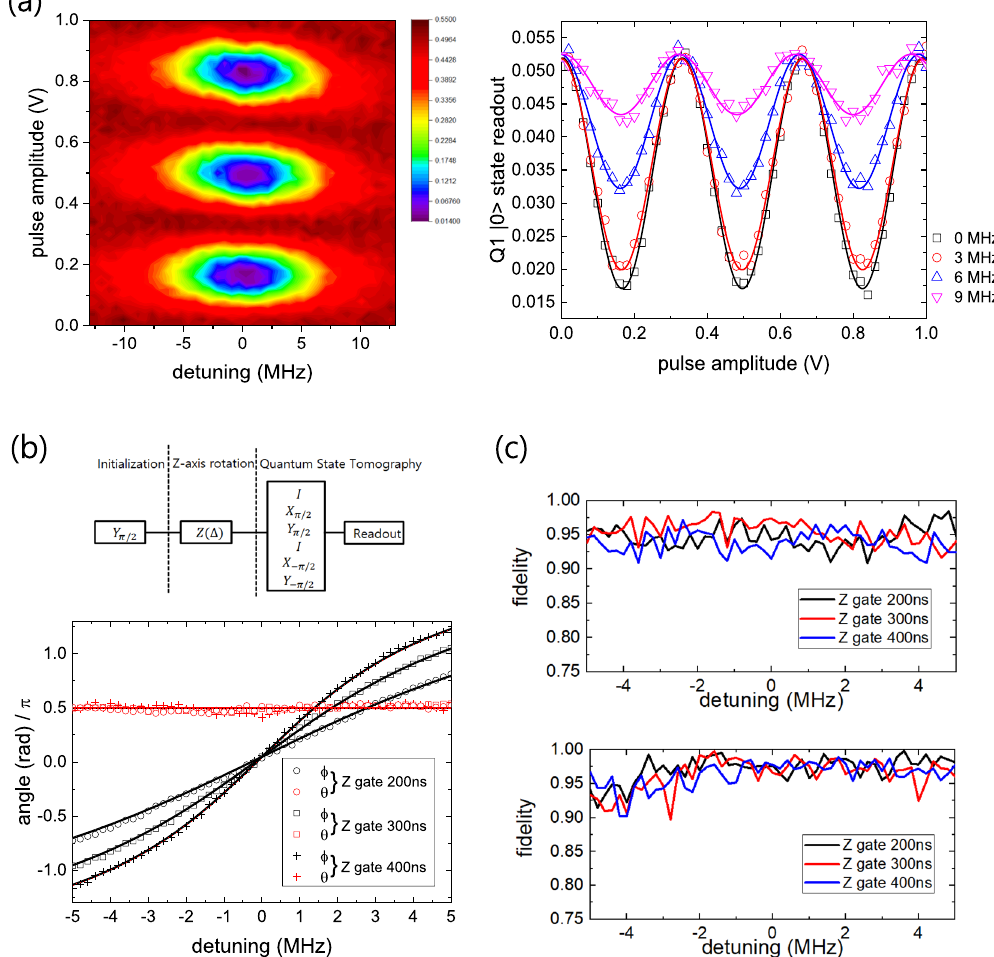
Figure 2. ( a ) Left: Detuning map of Rabi oscillation of Q1 driven by a microwave tone with hyperbolic secant pulse. Right: Rabi oscillations (taken from the left) with four different values of detuning Δ , 0 MHz, 3 MHz, 6 MHz, and 9 MHz. Here the pulse length was fixed to be 400 ns. ( b ) Demonstration of the Z-axis phase gate on Q1 based on hyperbolic secant pulse. The schematic sequence to perform a single-qubit QST after applying a Z-axis phase gate is illustrated above the plot. The results of the polar angle θ (red circle, square, and triangle) and the azimuthal angle φ (black circle, square, and triangle) for three different pulse lengths 200 ns, 300 ns, and 400 ns of 2 π cyclic rotation in the range of detuning − 5 MHz ≤ Δ ≤ 5 MHz are shown in the figure. ( c ) Estimated state fidelity for each quantum state constructed in ( b ) by performing single-qubit QST for Q1 (upper panel) and Q2 (lower